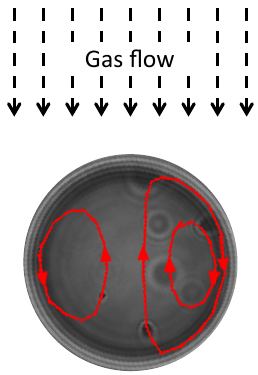
Fig. 4. Internal circulation patterns observed within a glycerol par- ticle at 85% RH. The focus of the microscope was set at approxi- mately half of the particle height, from which point all of the beads in the particle were visible and their x and y coordinates were de- termined. The red lines are the circulation patterns from monitoring three beads during one cycle of circulation within the particle where the circulation patterns are a 2-D projection of the bead movement in the x–y plane. The circulation patterns have been overlaid on the particle